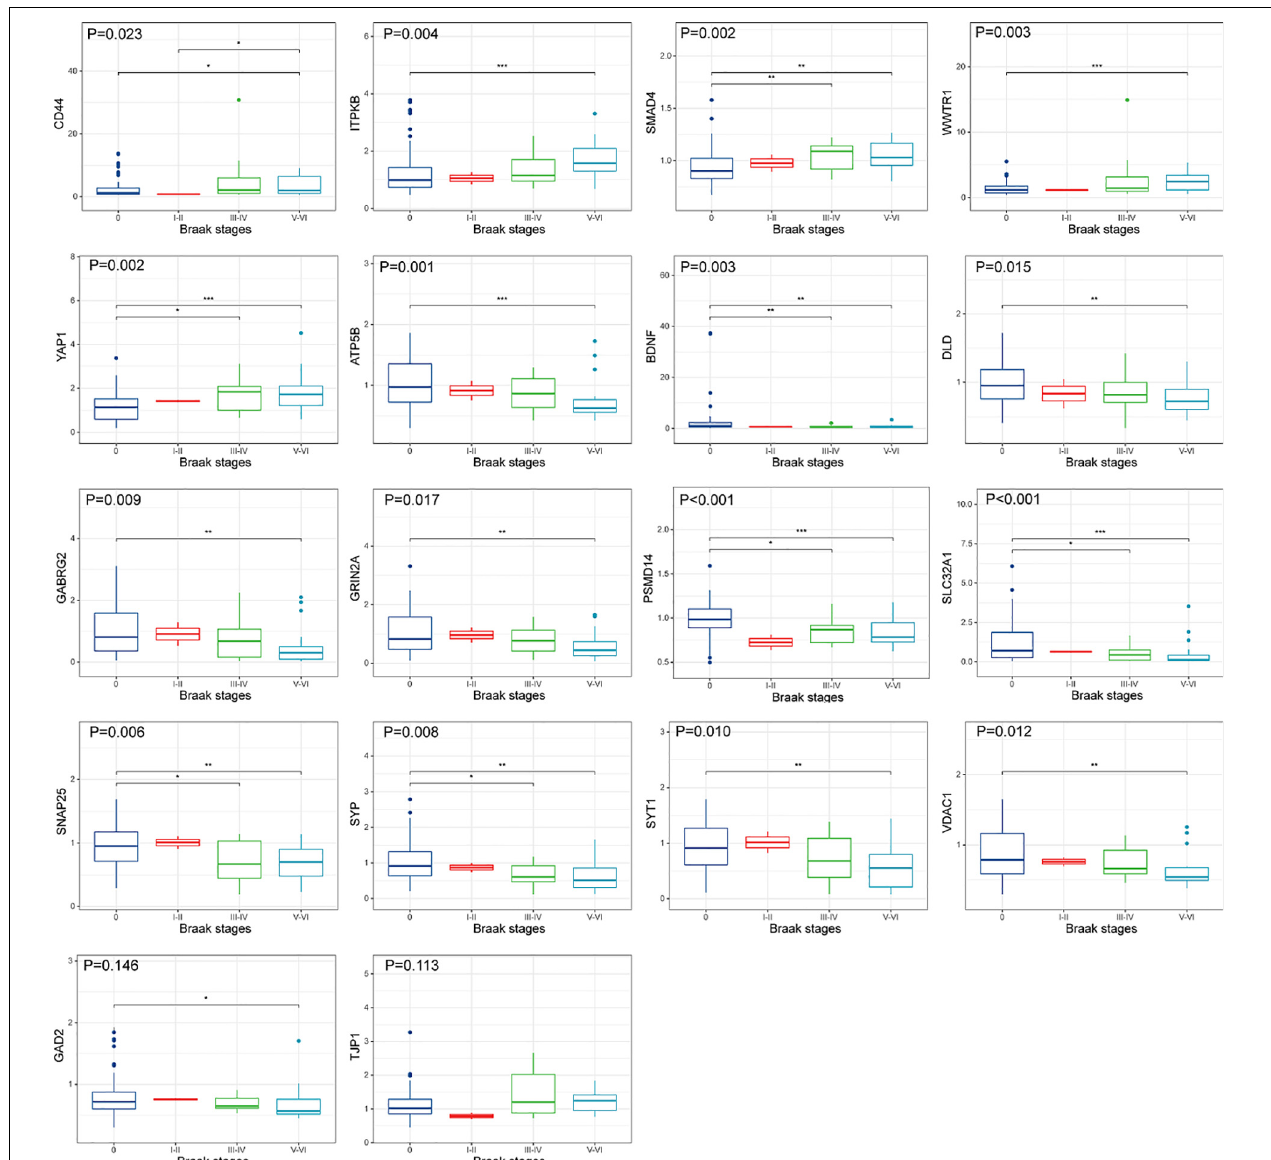
FIGURE 5 | Hub gene expression in different Braak stages of AD. The upper, middle, and lower horizontal lines of the box represent the upper, median, and lower quartiles, respectively. Overall differences between groups were tested with the K-W test. Asterisks indicate significant vs. Braak 0 groups; * p < 0.05; ** p < 0.01; *** p < 0.001 (dataset GSE48350; n = 91 for NDHCS; n = 2 for Braak stages I and II; n = 15 for Braak stages III and IV; n = 21 for Braak stages V and VI). AD, Alzheimer’s disease; NDHCS, non-demented healthy control subjects; HPC, hippocampus; PFC, prefrontal